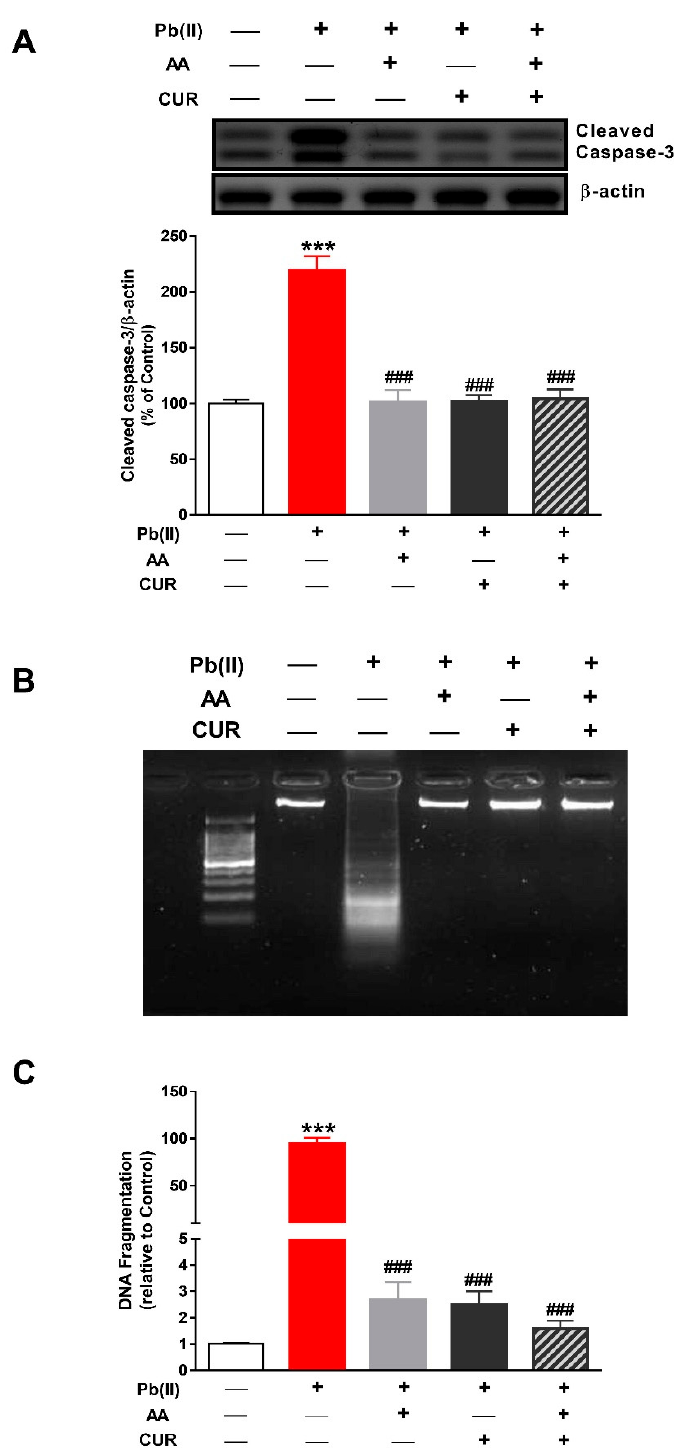
Figure 6. CUR attenuates apoptosis in Pb(II)-induced rats. CUR, AA and their combination diminished caspase-3 activation ( A ) and DNA fragmentation ( B , C ) in liver of Pb(II)-intoxicated rats. ( B , C ) Data are expressed as mean ± SEM, ( n = 6). *** p < 0.001 versus control and ### p < 0.001 versus Pb(II).